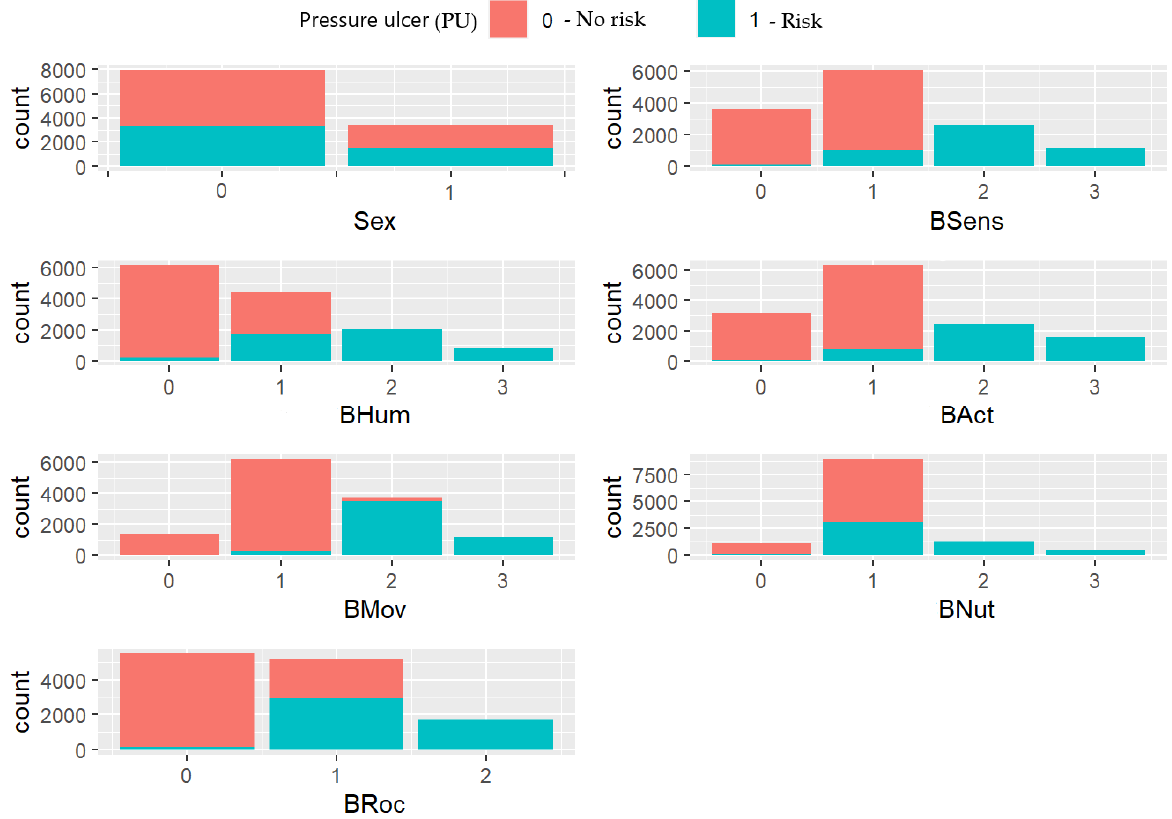
Figure 1. PU risk classification based on individual subscales.